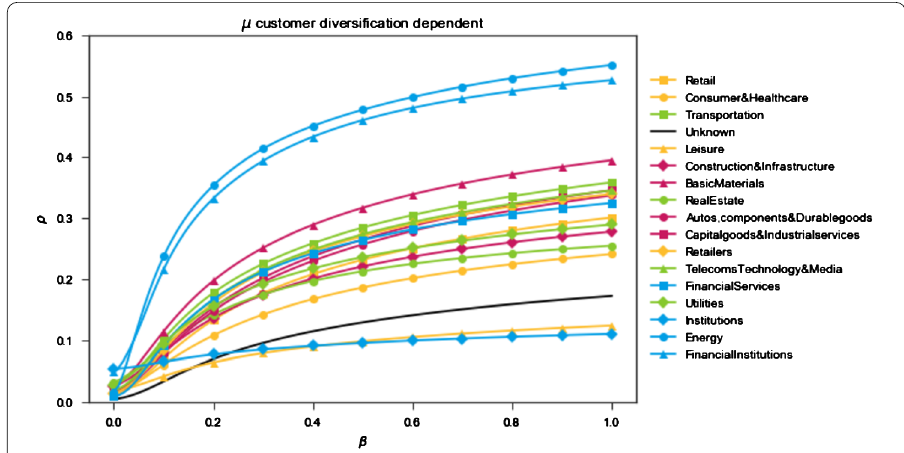
Figure 5 Sectoralrecoveryratedependenceofthefractionofinfectednodes . Sector ρ ( β , μ ) distribution when μ is heterogeneous